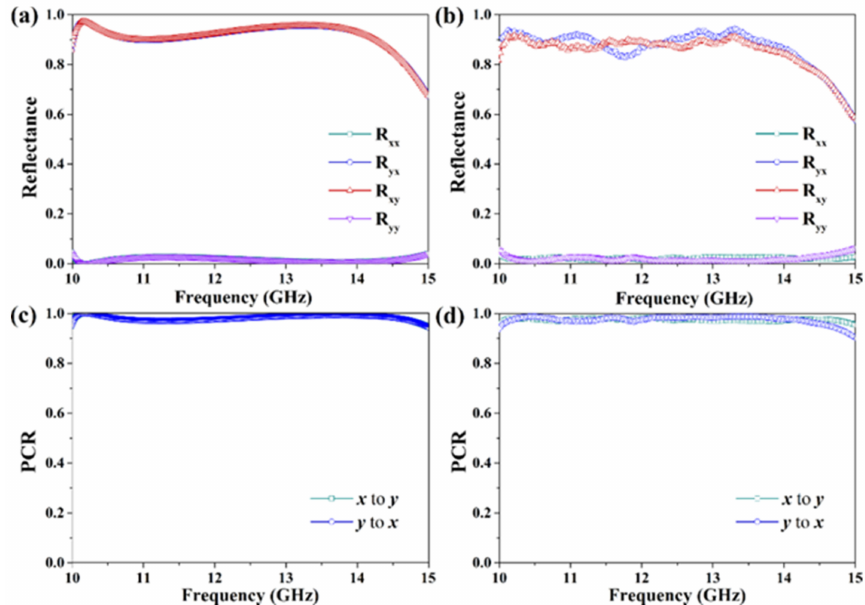
Figure 5. Simulation (left column) and experimental (right column) results of the proposed metagrating for the x - and y -polarized incident waves in the reflective mode. ( a , b ) Reflectance, ( c , d )